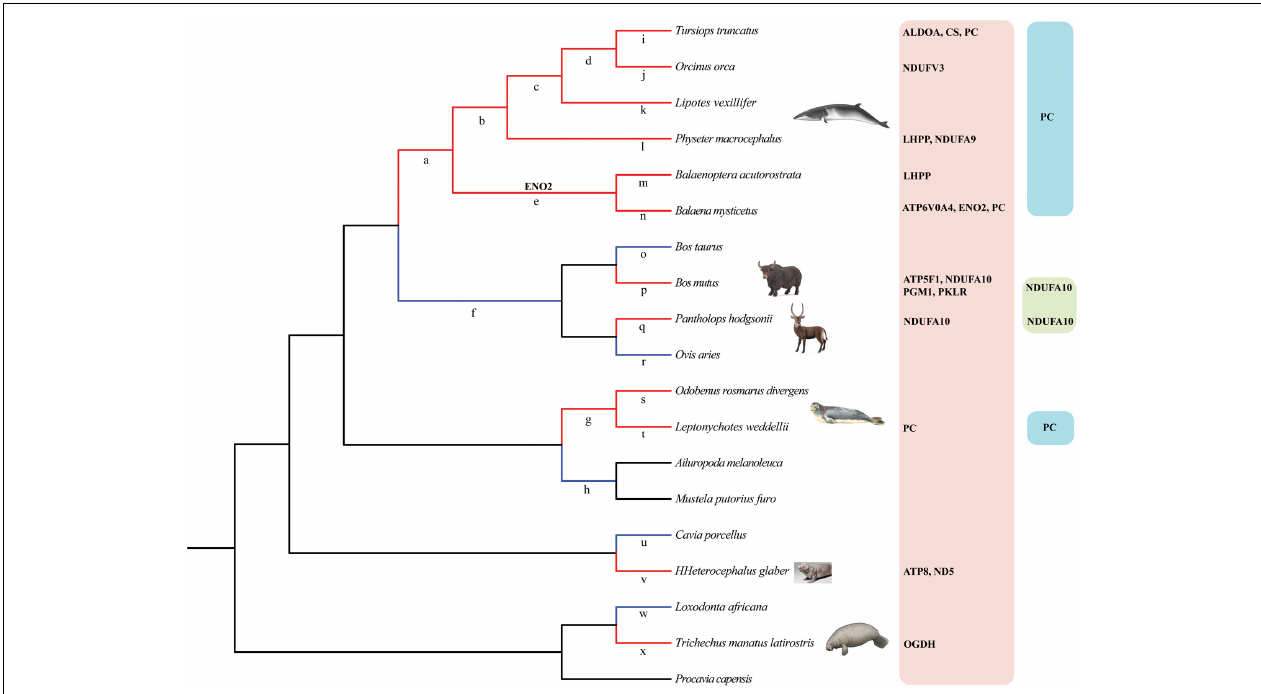
FIGURE 2 | Phylogenetic tree representation of energy metabolism genes under positive selection in hypoxia-tolerant mammals. Red and blue color branches in the tree denote hypoxia-tolerant mammals and their sister taxa, respectively. Branches a-x in the tree were used in branch-site tests. PSGs ( PC , NDUFA10 ) shared by two or more hypoxia-tolerant species were also listed in the rightmost part of the Figure 2 .